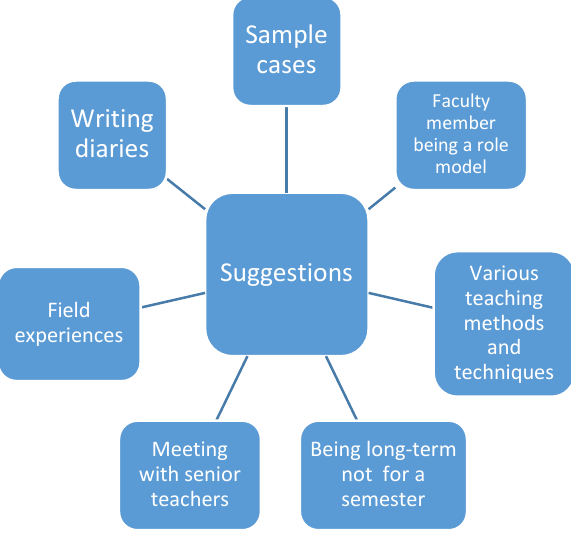
Figure 2 . Suggestions for the development of prospective teachers' ethical